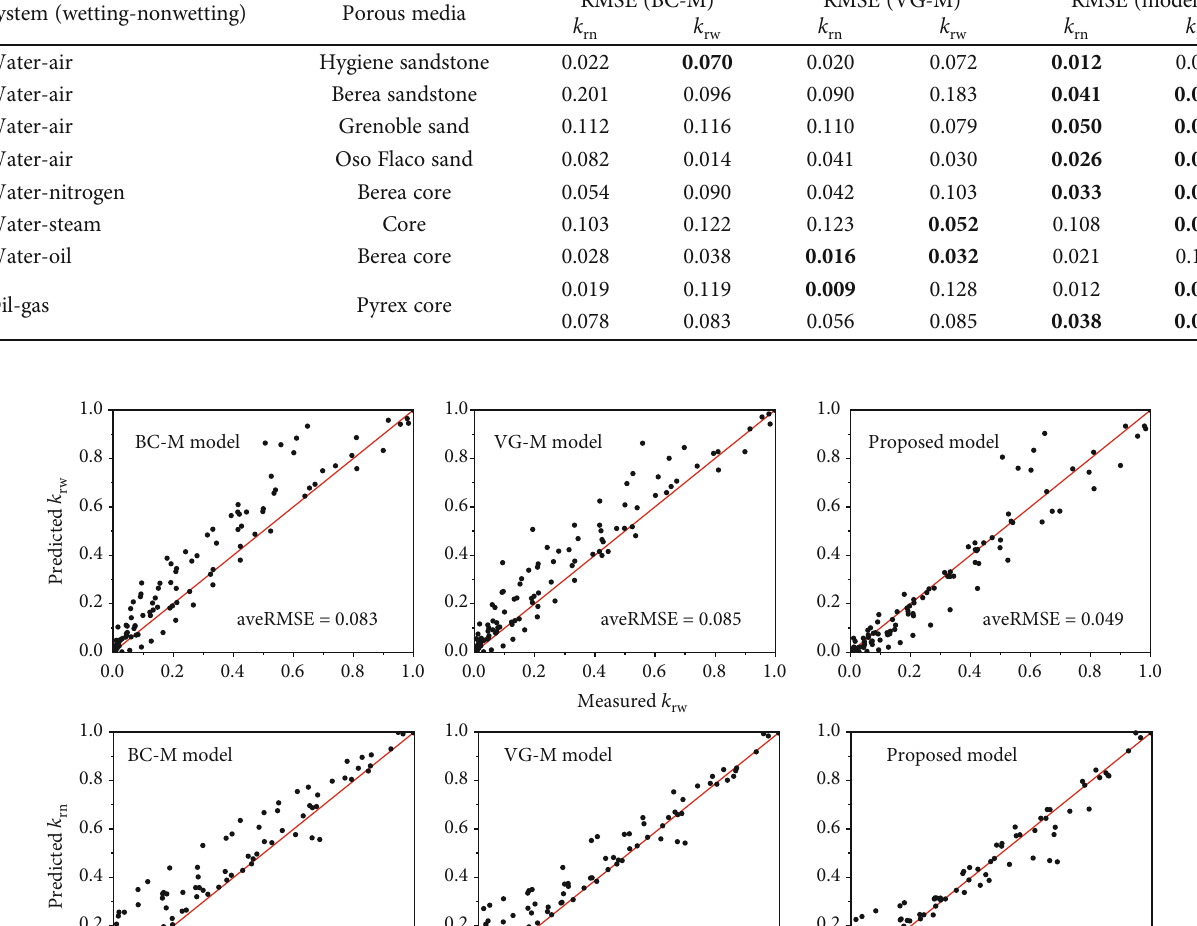
Table 3: RMSE values obtained with the BC-M, VG-M, and proposed models. System (wetting-nonwetting)